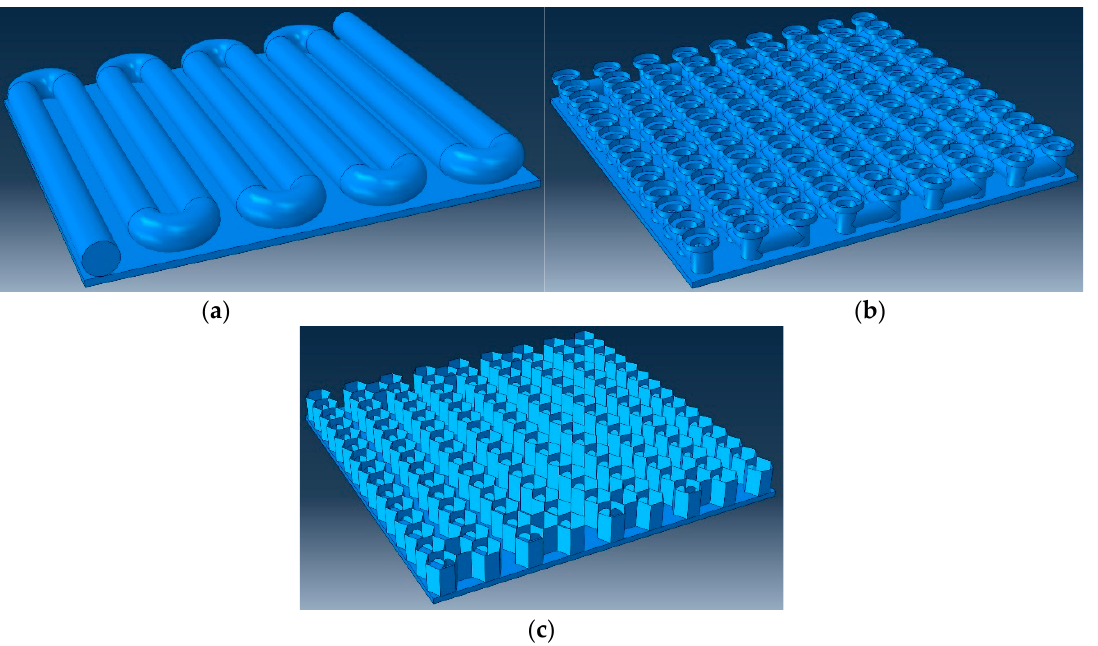
Figure 2. Proposed conceptual designs core shapes ( a ) tubular ( b ) mushroom ( c ) honeycomb.